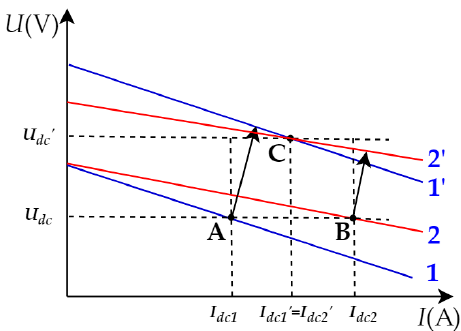
Figure 9. The adjustment effect diagram of the traditional double compensation secondary control